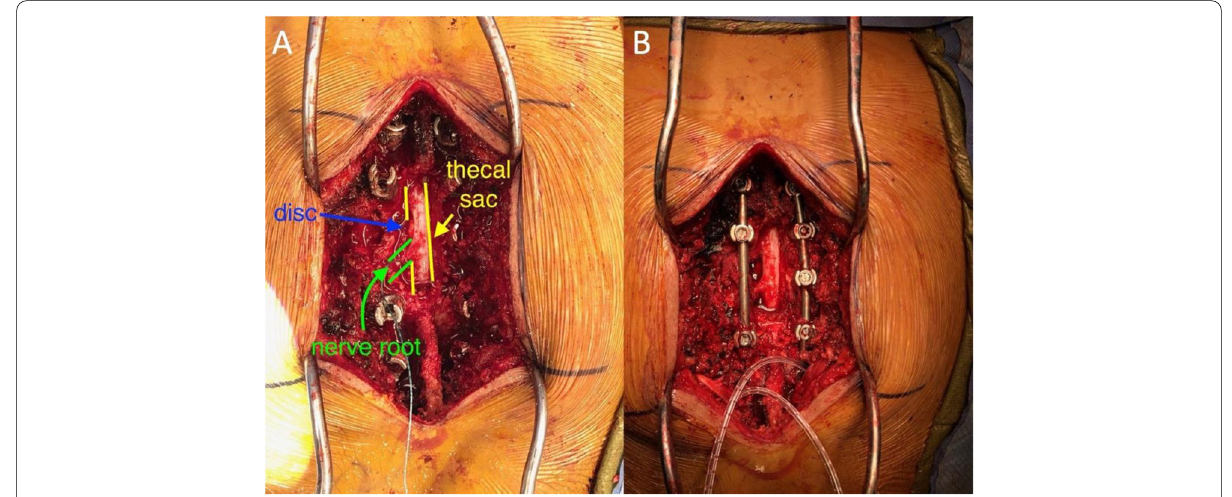
Fig. 3 A Interop photograph demonstrating posterior exposure s/p laminectomy, left T7-T8, T8-9 facetectomy, costotransversectomy, and removal of left T8 pedicle prior to resection of disc herniation. Herniation can be seen causing significant tension on the thecal sac and spinal cord. B Interop photograph following partial corpectomy and discectomy with circumferential decompression of the spinal cord. Instrumentation